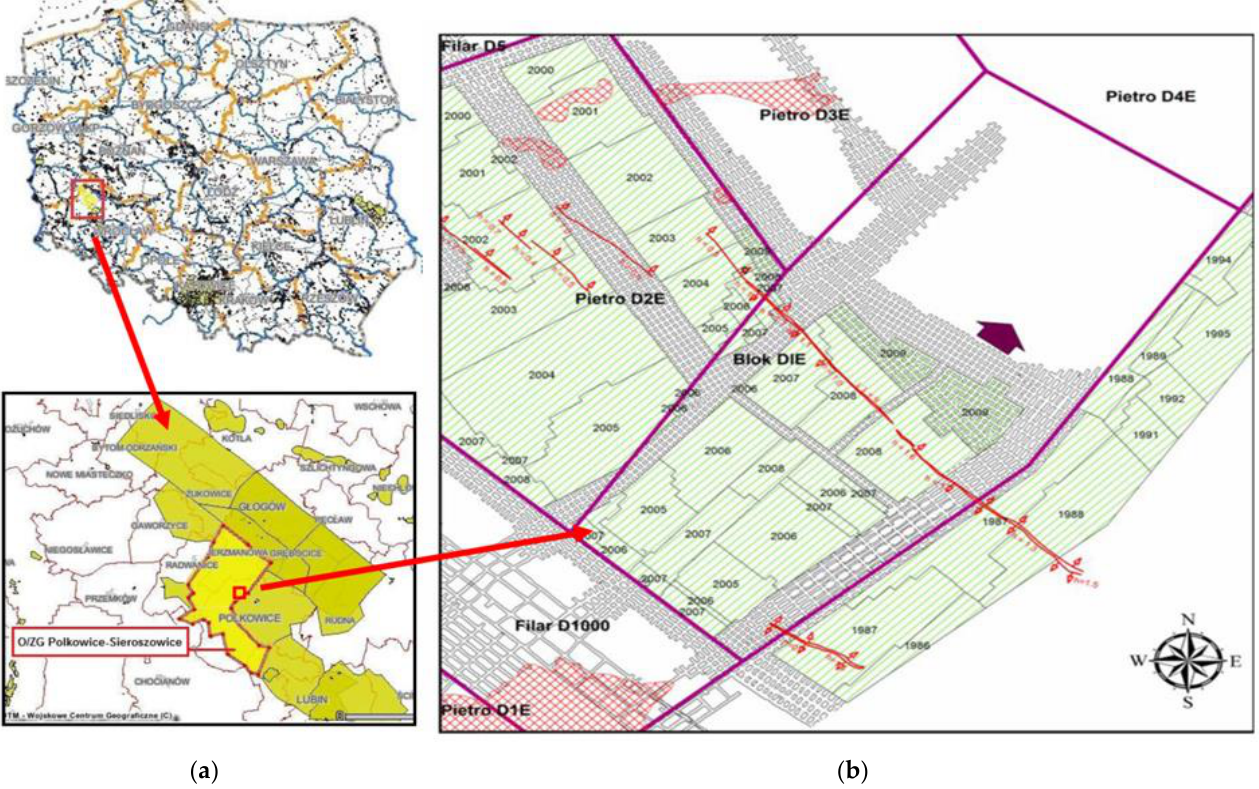
Figure 1. Location of the LGCB in Poland, location of the analyzed mining field in the Polkowice-Sieroszowice mine ( a ), analyzed mining field and location of the remnant ( b ).